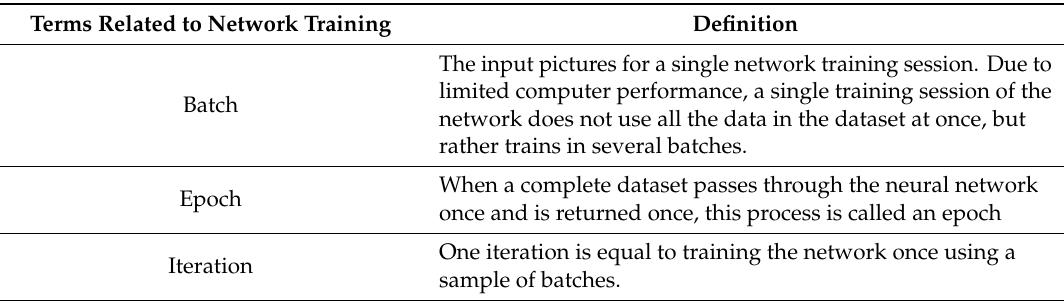
Table 3. Definition of terms related to network